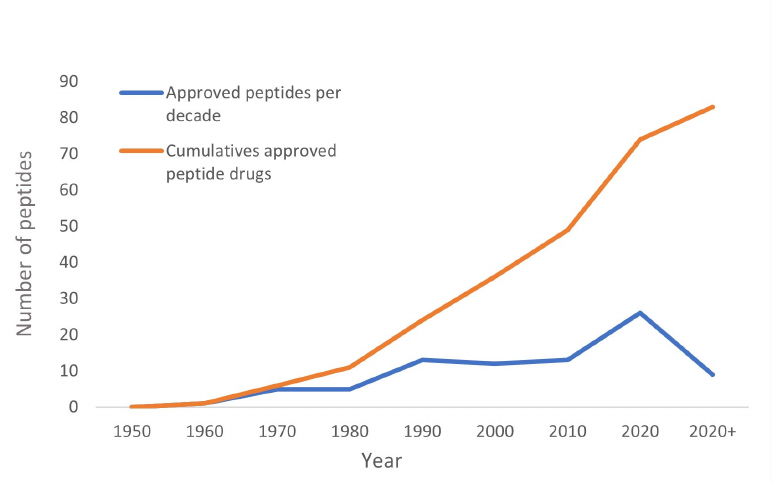
Figure 1. Increasing number of approved peptides in the United States, Europe, and Japan [3,4]. Table 1. Approved peptide drugs in the United States, Europe, and Japan from 2020.